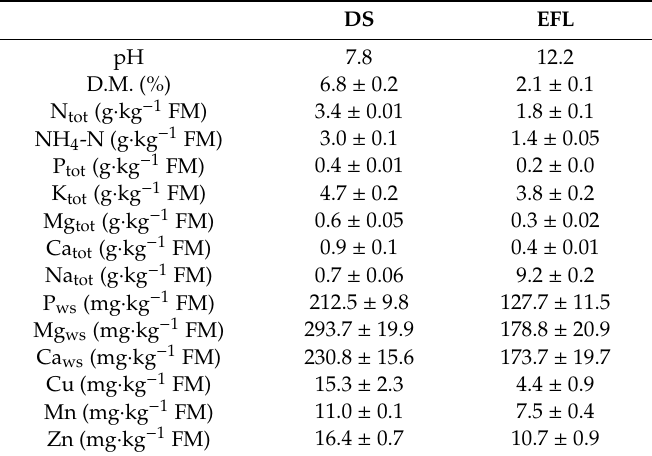
Table 1. The physicochemical properties of digestate (DS) and e ffl uent from the biorefinery (EFL)